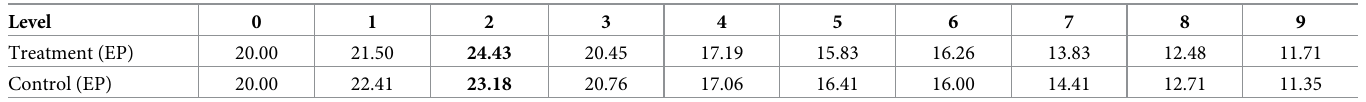
Table 4. Expected payoffs from the distribution of level-k beliefs.